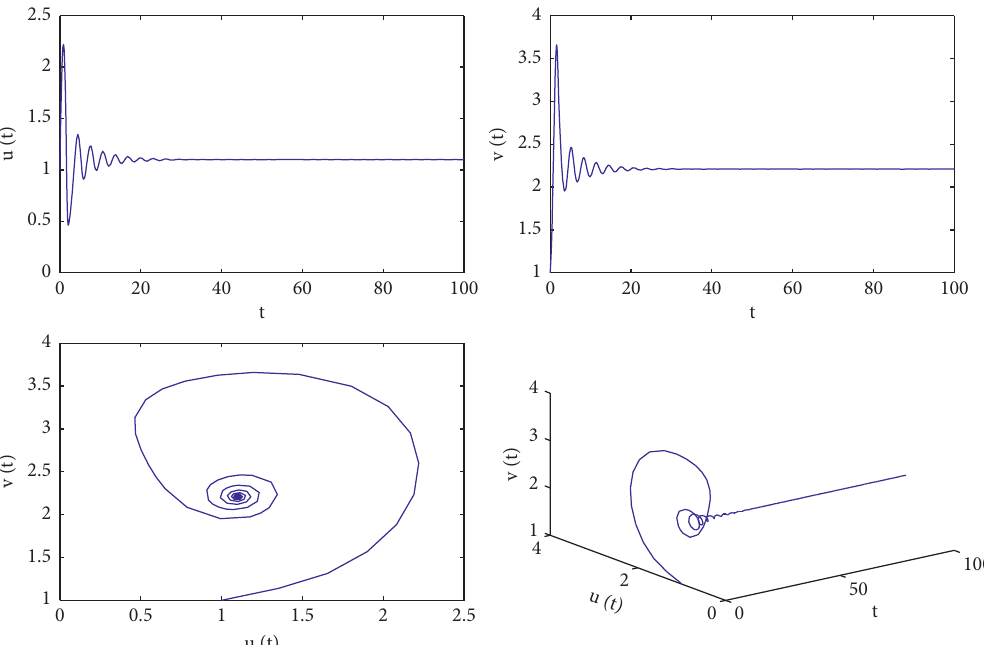
Figure 4: The trajectories graphs and phase graphs of system (94) with τ